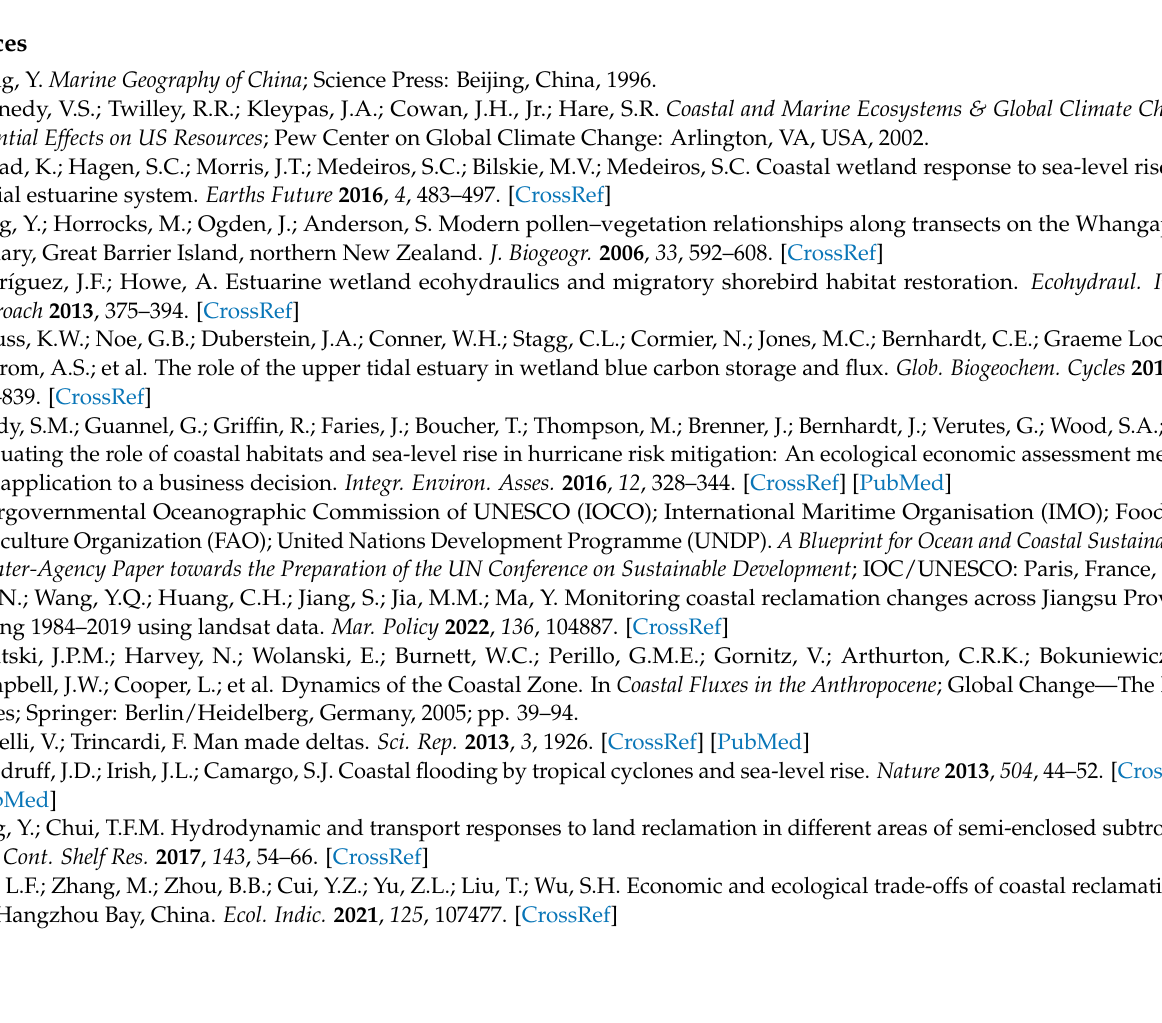
Figure S3: Influence of reclamation cases on the hydrodynamic environment; Table S1: Variation range of tidal flux at each section of the water channel; Table S2: The variation of flood tide velocity in each case; Table S3: Tidal flux variation of each section under stable topography with fixed bed and equilibrium in case 8%; Table S4: Characteristic point changes of flow